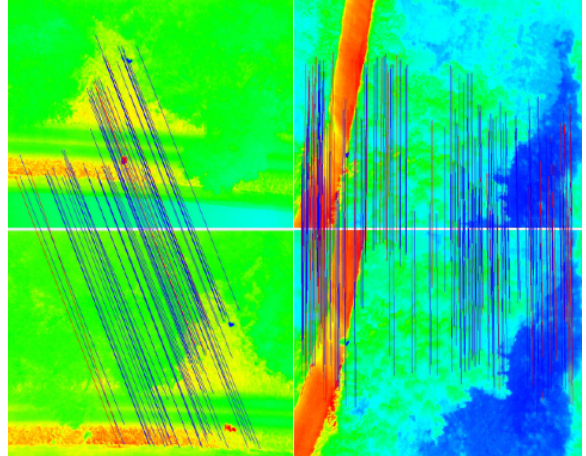
Figure 9L: Thermal image pair at test site "Pfynwald" with valid tie point matches (2-11 °C). Figure 9R: Thermal image pair at test site "Rietholzbach". The image pair in Fig. 9L reveals the weak correspondence between both images (only 85 valid correspondence links).